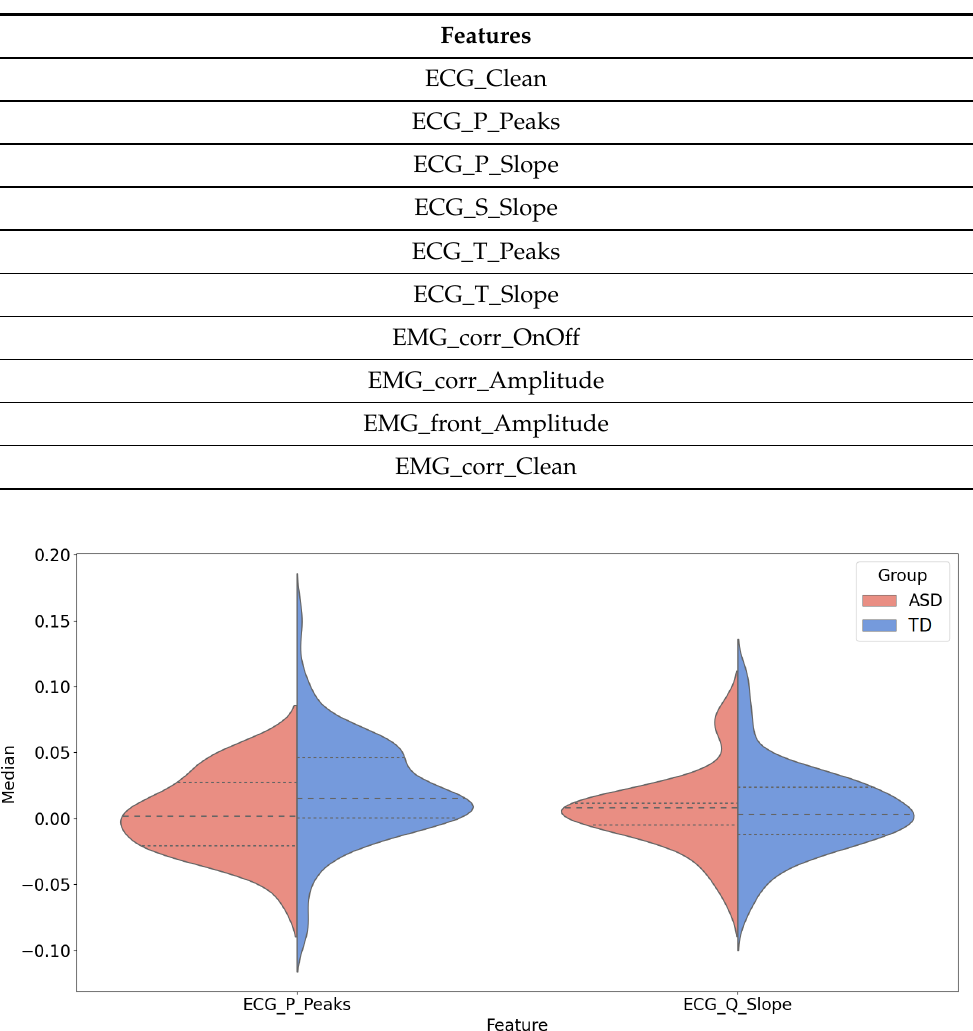
Table 3. The features for which the Mann–Whitney test revealed a significant difference between the ASD and TD groups.